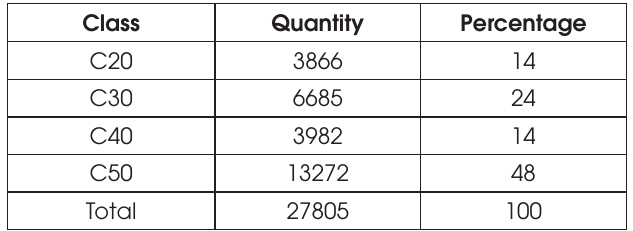
Quantification of the specimens by Brazilian regions Region